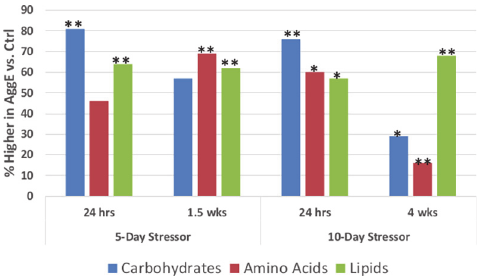
Figure 2. Percent of metabolites of metabolic fuels higher in AggE vs. Ctrl mice. The Carbohydrate, Amino acid and Lipid superpathways are comprised of 21, 98, and 134 metabolites, respectively. Asterisks indicate p (cid:1) 0.05 ( * ) and p (cid:1) 0.01 ( ** ) for obtaining the percent elevated metabolites shown (exact binomial